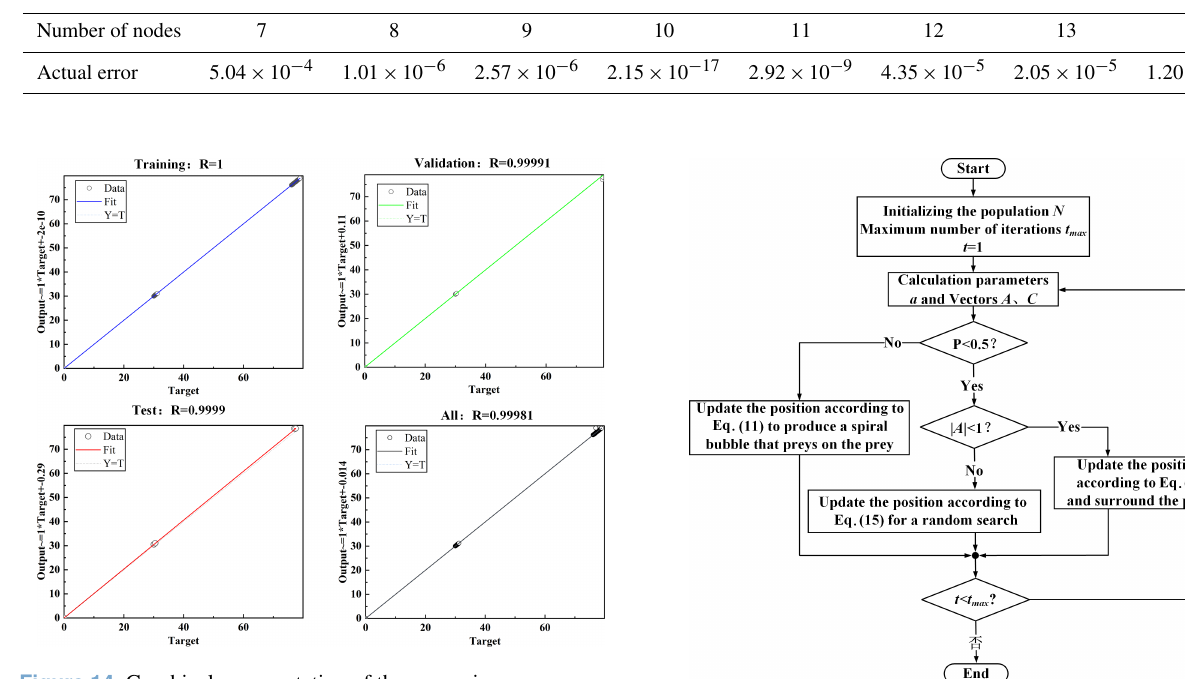
Figure 14. Graphical representation of the regression curve.